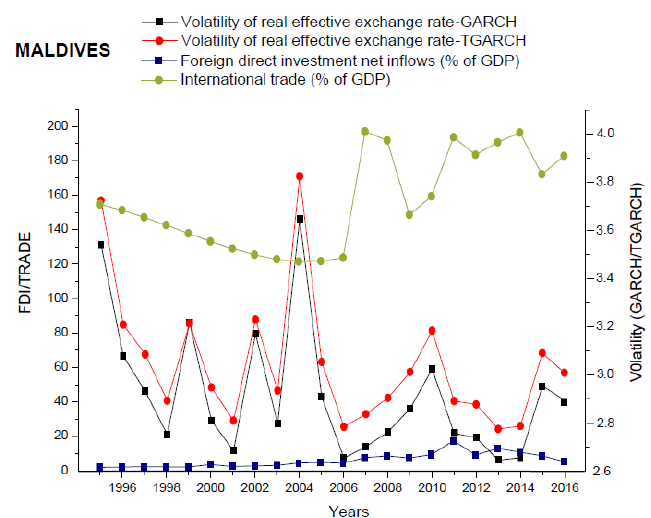
Figure 4. Exchange Rate Volatility vs. FDI/Trade (Maldives).